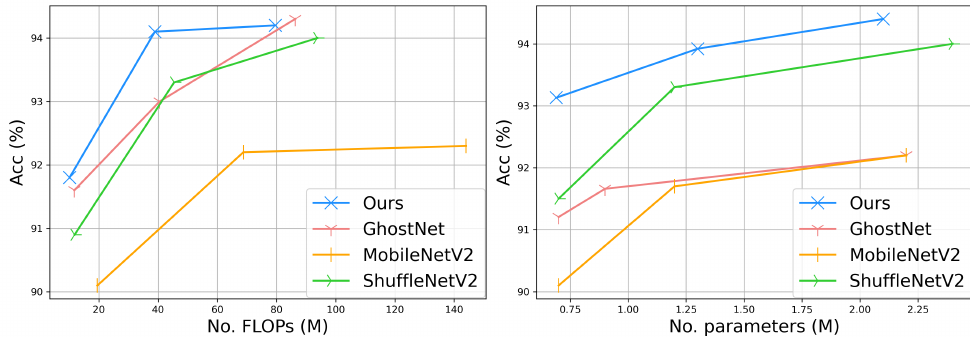
Figure 2. Performance under different parameter budgets and FLOPs on